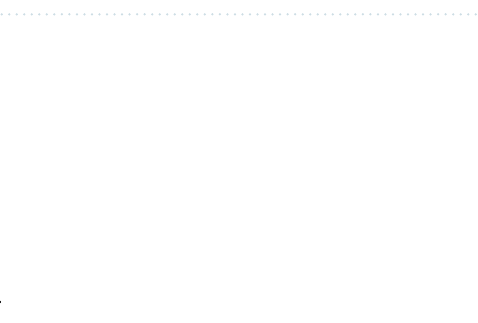
Figure 5a demonstrats the fingernail inserted into the detection aper- ture with only the cusp of the fingernail being detected. Figure 5b shows a typical fingernail EPR spectrum